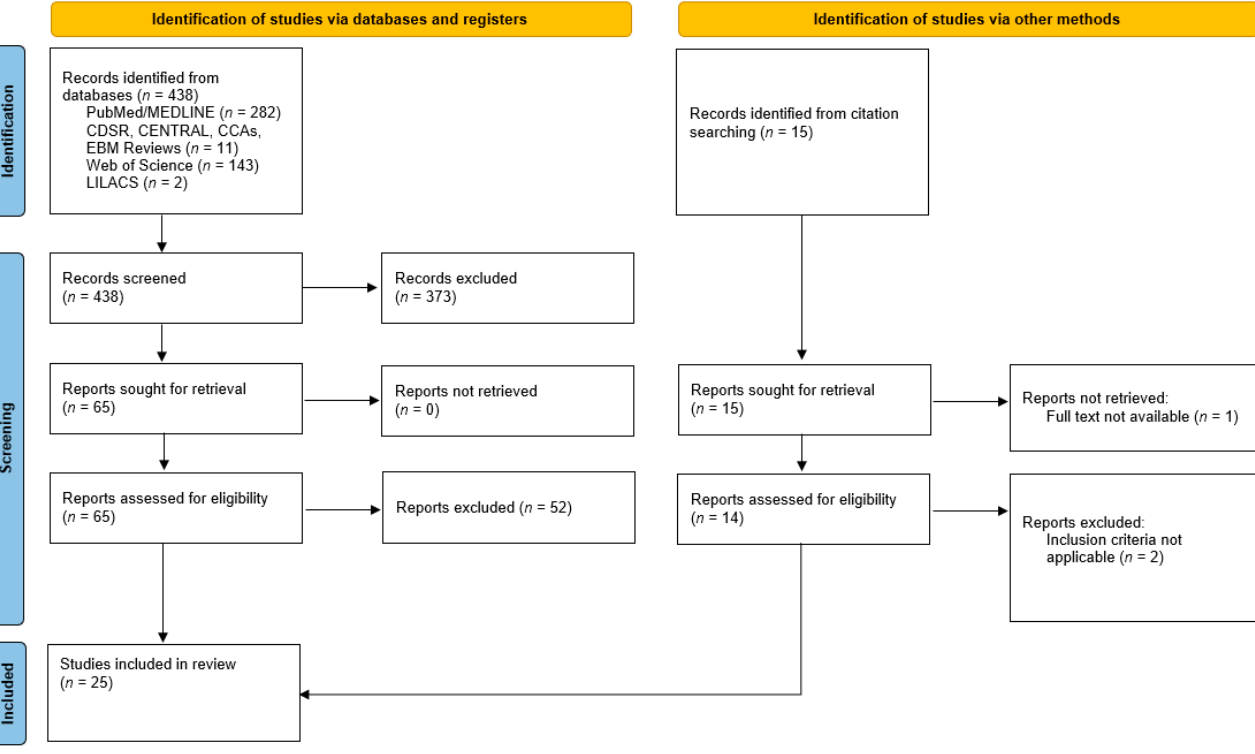
Figure 2. PRISMA flowchart of the study